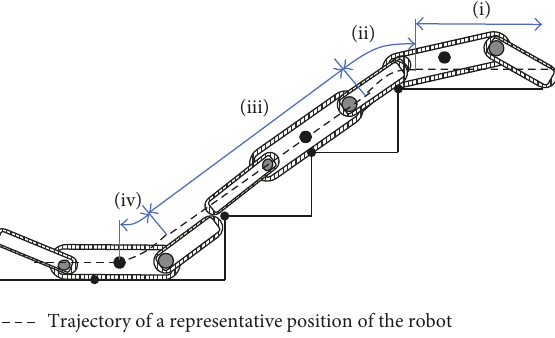
Figure 2: Three motion phases when climbing up.